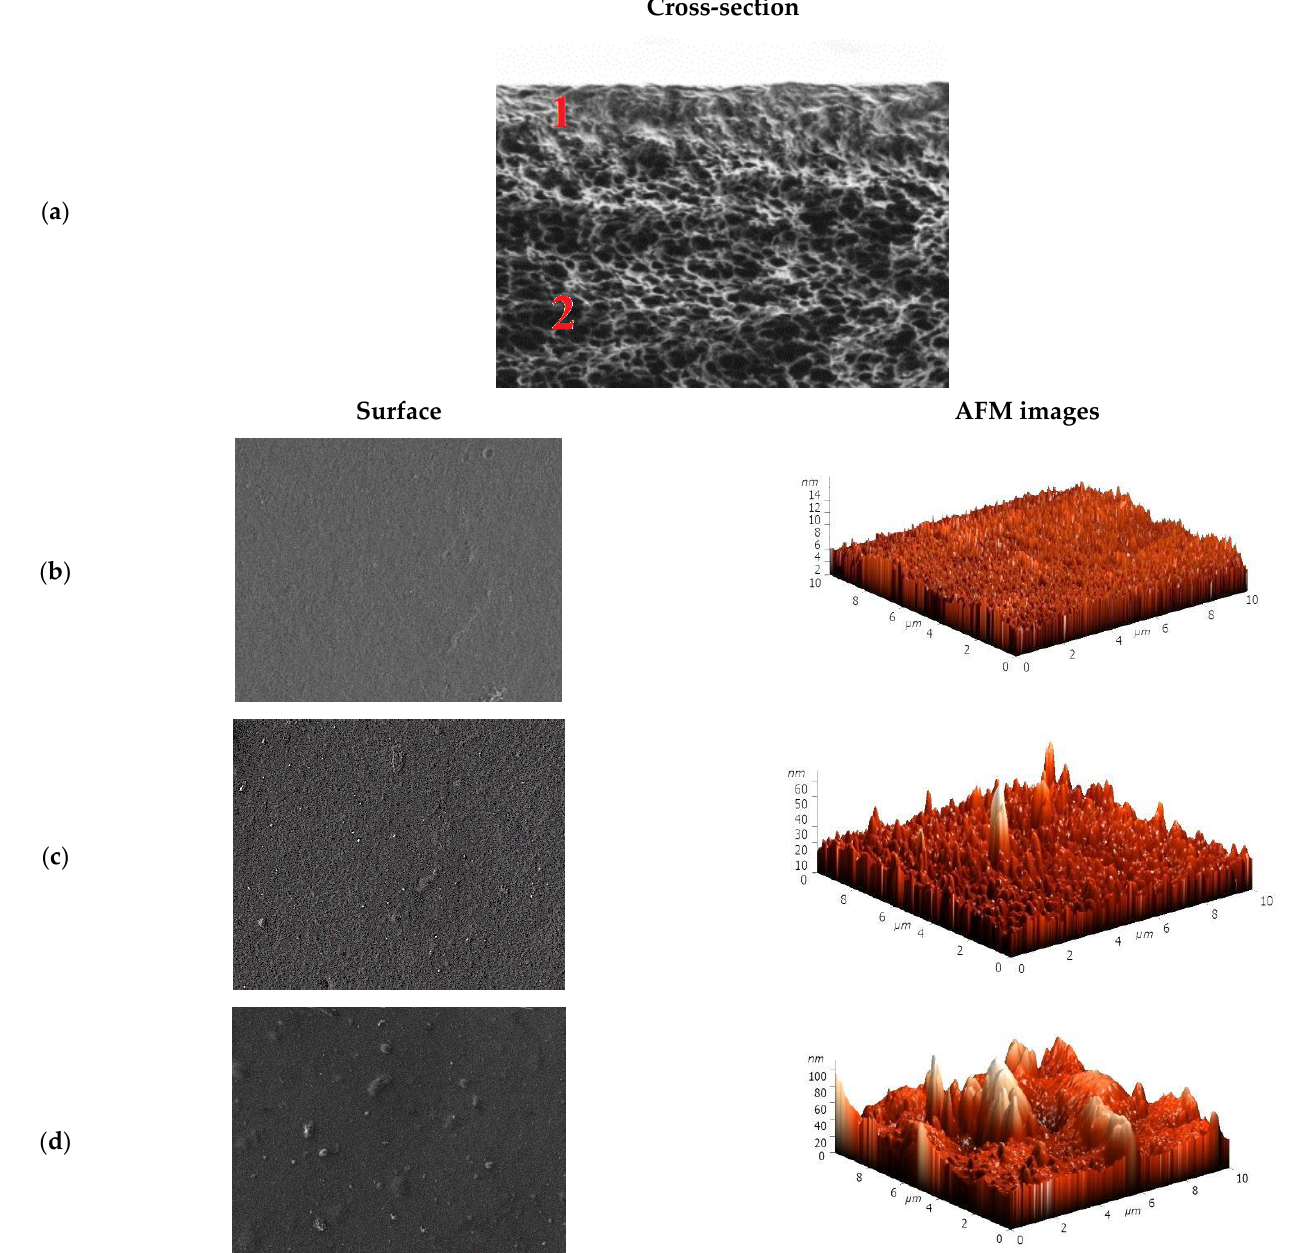
Figure 3. ( a ) The cross-sectional micrograph of the SA/PAN membrane, surface SEM micrographs, and AFM images of the supported ( b ) SA/PAN, ( c ) SA-5HF/PAN, and ( d ) SA-5AF/PAN membranes.